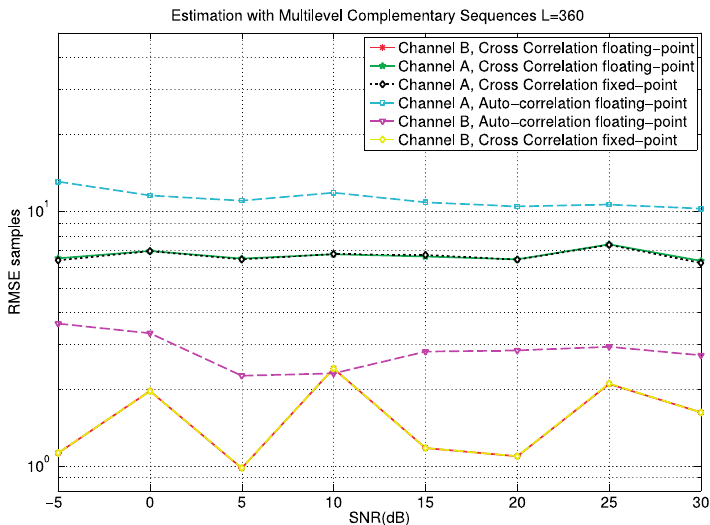
Figure 10. RMSE in the synchronization delay estimation for both channels, and for a floating- and a fixed-point representation and the auto-correlation method.